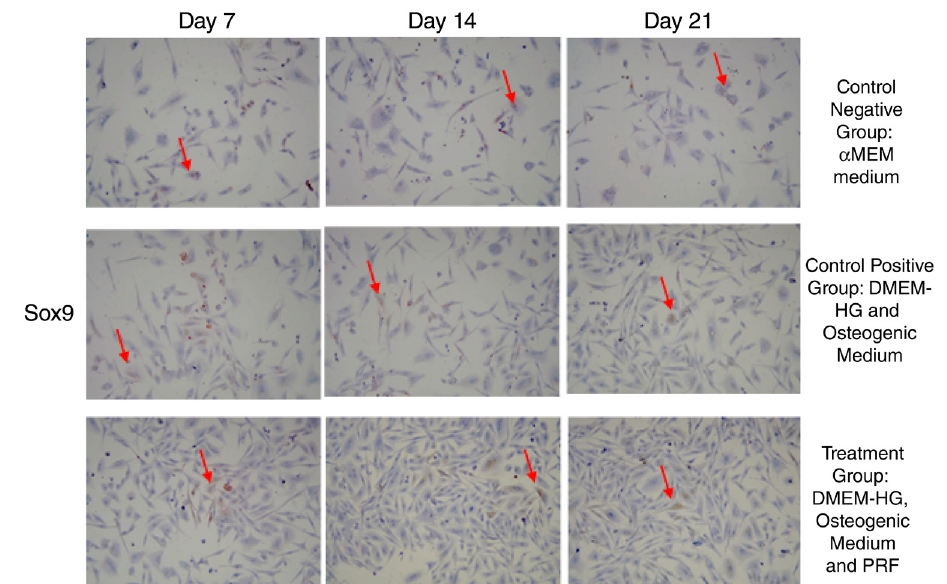
Figure 3. Sox9 expression in gingival stromal progenitor cells (GSPCs) of Wistar rats ( Rattus Novergicus ). (A-C) Sox9 expression in the negative control group; (D-F) Sox9 expression in the positive control group; (G-I) Sox9 expression in the treatment group. Sox9 expression in GSPCs was observed on Days 7, 14 and 21. Positive Sox9 expression is highlighted in brown (red arrow) following examination at 200x magnification (n=1).